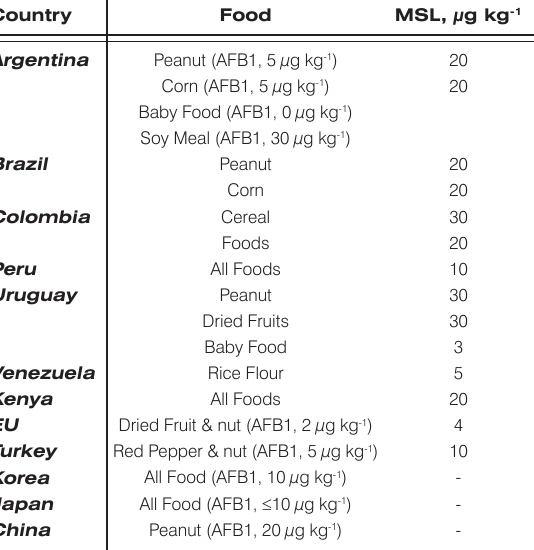
Table 1. Maximum safe levels of total aflatoxin and AFB1 for some countries. Country